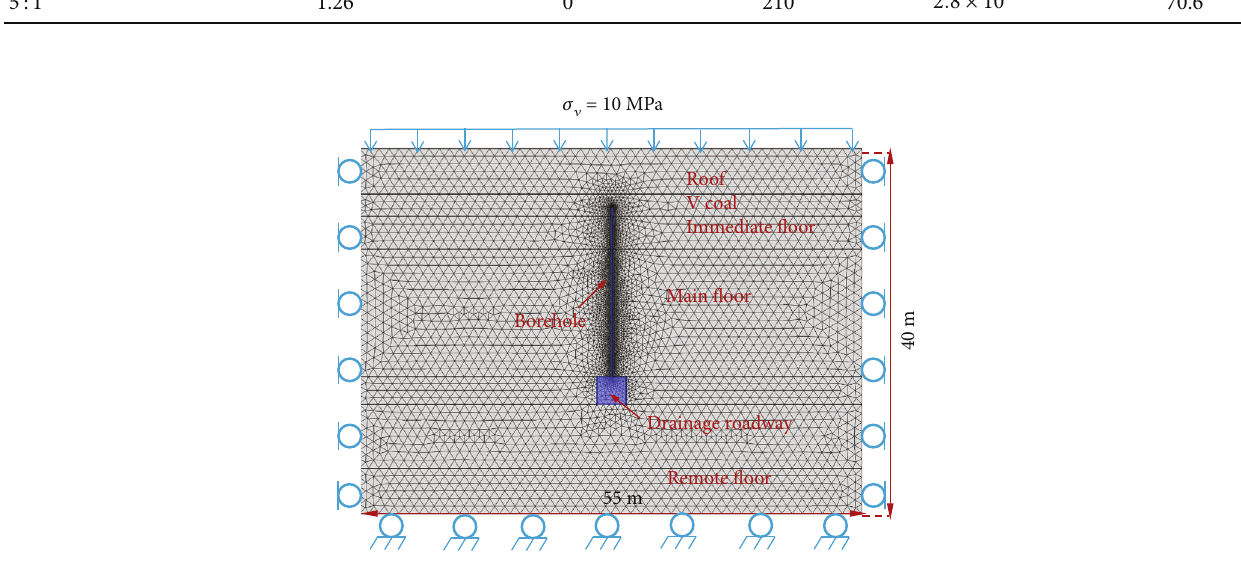
Figure 6: Coupling model of grouting di ff usion in the layer-through Table 2: Physical parameters of rock strata in the simulation model.